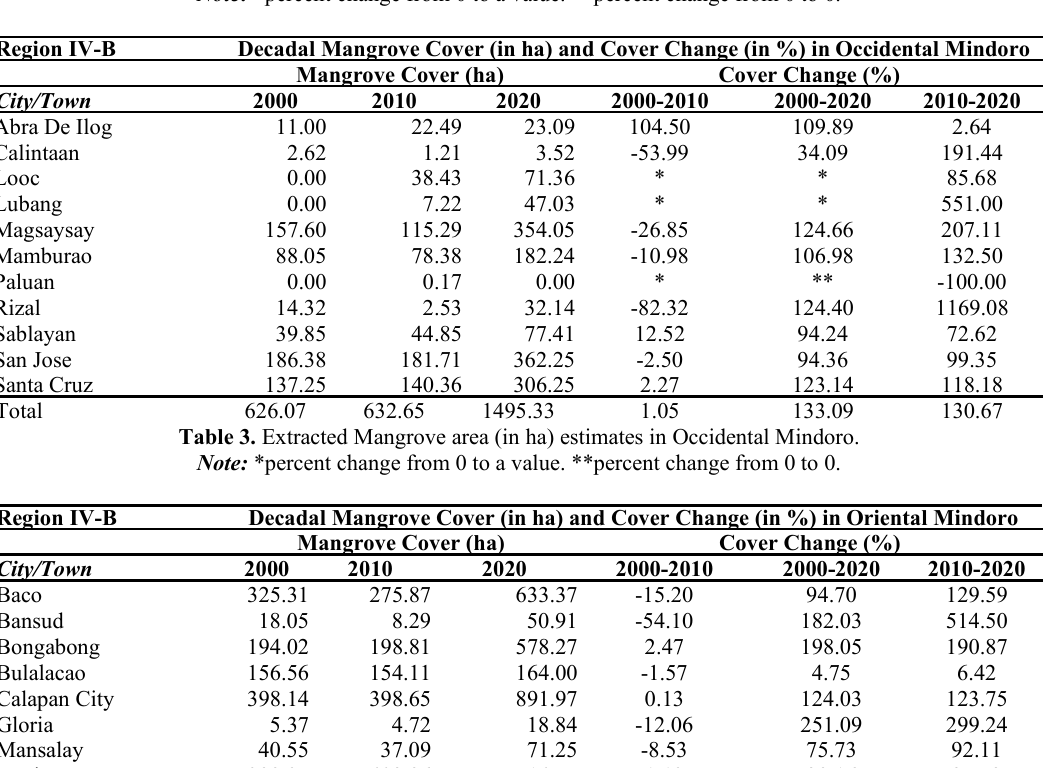
Table 2. Extracted Mangrove area (in ha) estimates in Marinduque. Note: *percent change from 0 to a value. **percent change from 0 to 0.